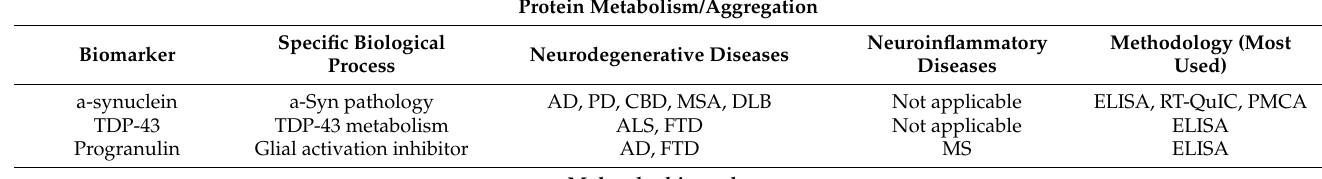
Table 3. CSF-based biomarkers tracking protein pathologies and novel molecular biomarkers. Protein